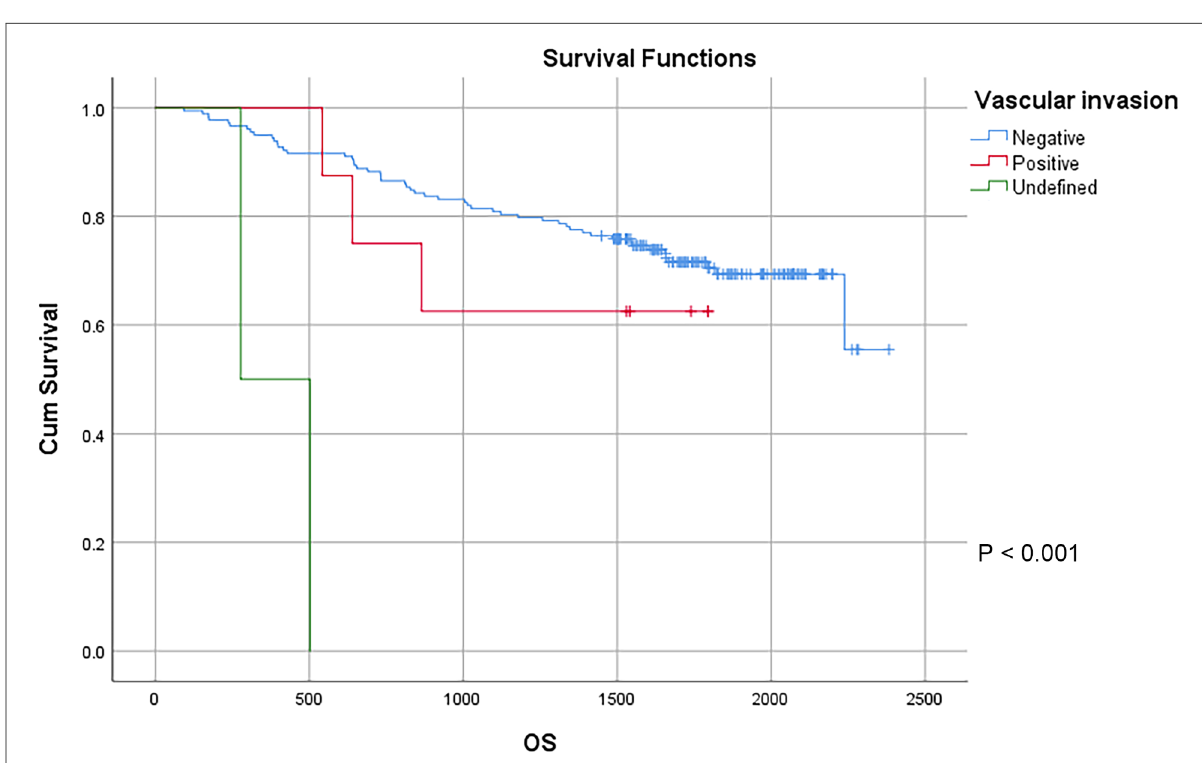
FIGURE 5 Survival curves of colon cancer patients in different vascular invasion